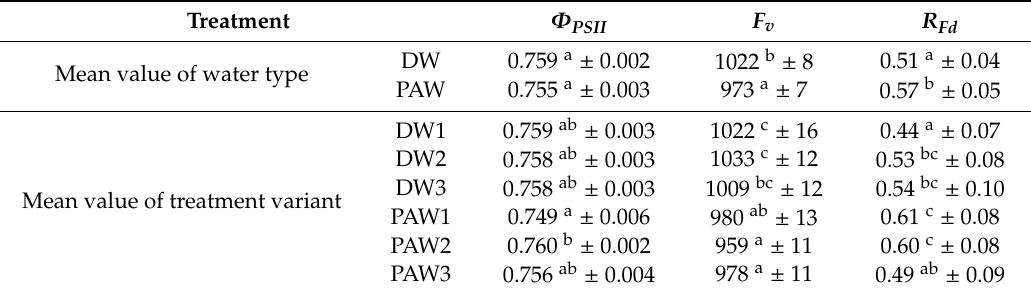
Table 4. Influence of PAW application on chlorophyll fluorescence